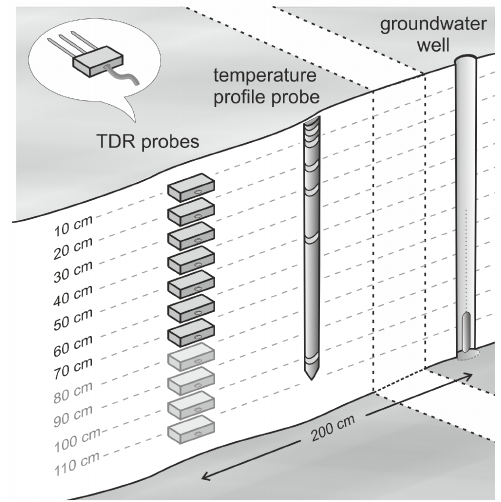
Figure 2. Sketch of a representative monitoring station of the STH-